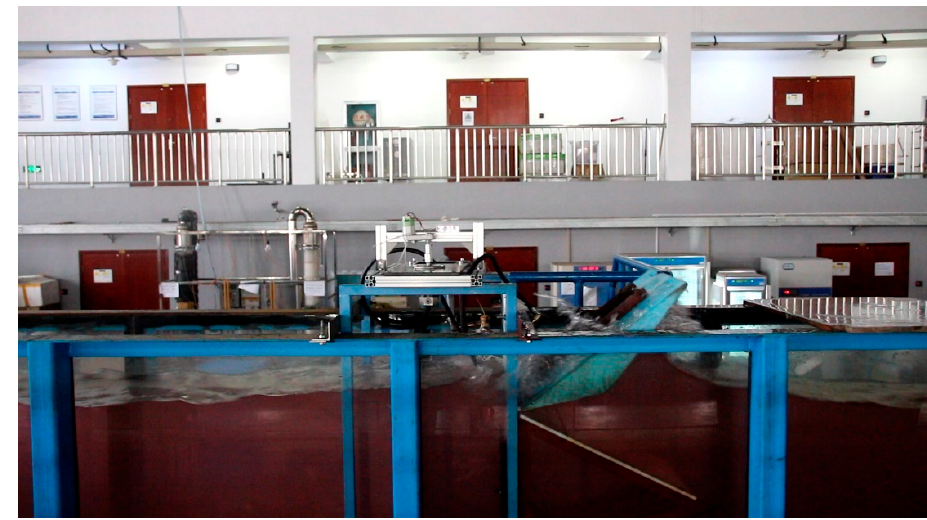
Figure 9. Physical model preliminary test.